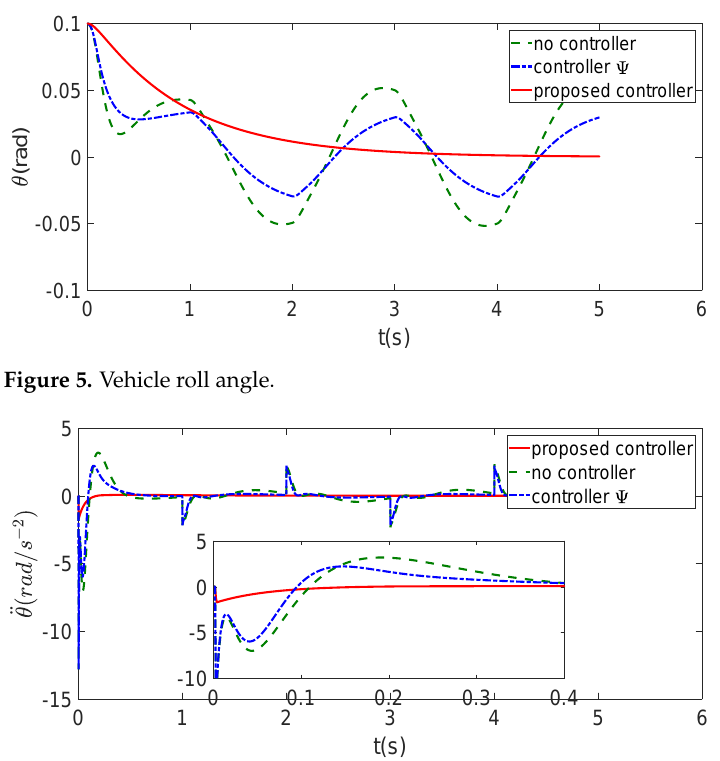
Figure 6. Vehicle roll angular